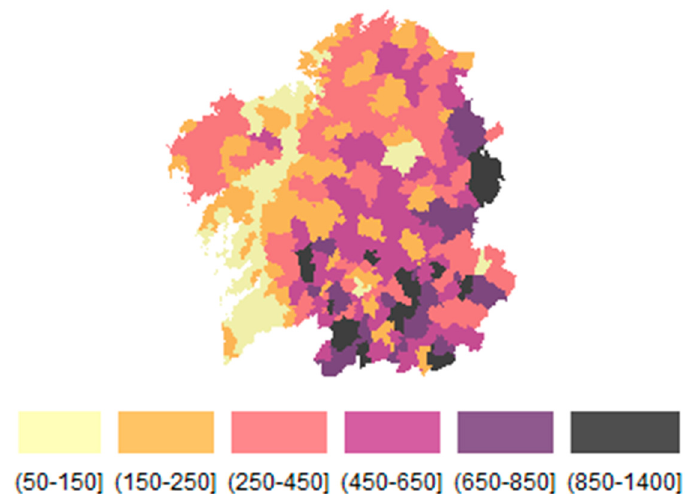
Figure 5. Aging index. Information by municipalities (2020). Source: National Institute of Statistics. Demographic indicators. Table 12. Spatial autocorrelation of I and the p Table 2. Population (inhabitants). Sources: own elaboration based on data from the Galician